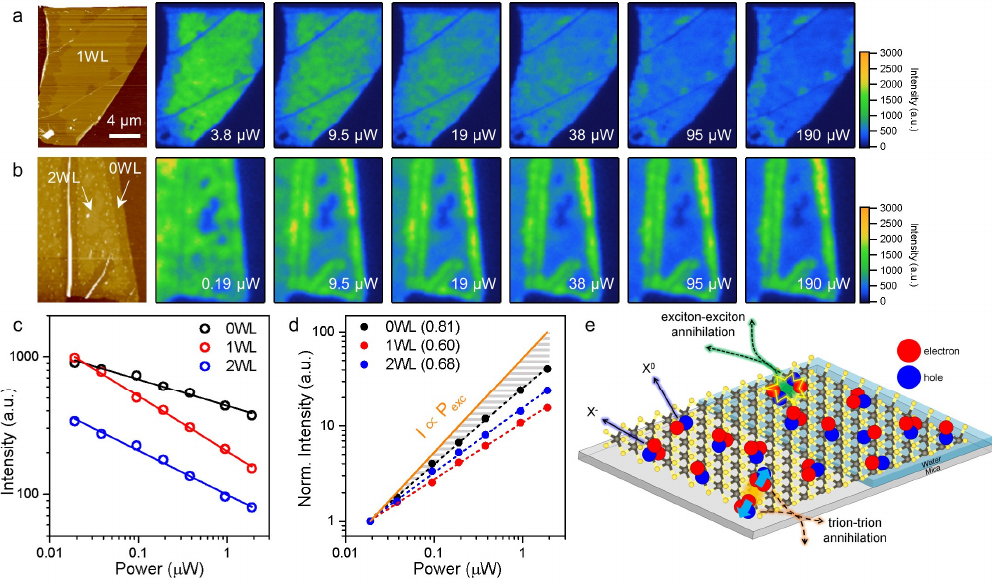
Figure 3. Wide-field PL imaging of power-dependent intensity inversion. ( a ) AFM (leftmost) and PL (the others) images of WS 2 /mica with 0WL and 1WL areas. ( b ) AFM (leftmost) and PL (the others) images of WS 2 /mica with 0WL, 1WL and 2WL areas. Whereas P exc was increased in ( a , b ), the corresponding exposure time was decreased reciprocally for a constant photon fluence. ( c ) Integrated PL intensity of the X − and X 0 peaks for the 0WL, 1WL and 2WL areas of ( b ). Each PL spectrum was obtained for a constant photon fluence while varying P exc . Note that P exc for the PL imaging was two orders of magnitude larger than that for the PL spectra in ( c ) because of a large illumination area for the imaging. ( d ) Normalized PL intensity (I) from ( c ) given as a function of P exc . Each data point in ( c ) was divided by its exposure time and then normalized with respect to the value at the lowest P exc . ( e ) Schematic representation of exciton–exciton annihilation (EEA) and trion–trion annihilation (TTA) in WS 2 /water/mica.